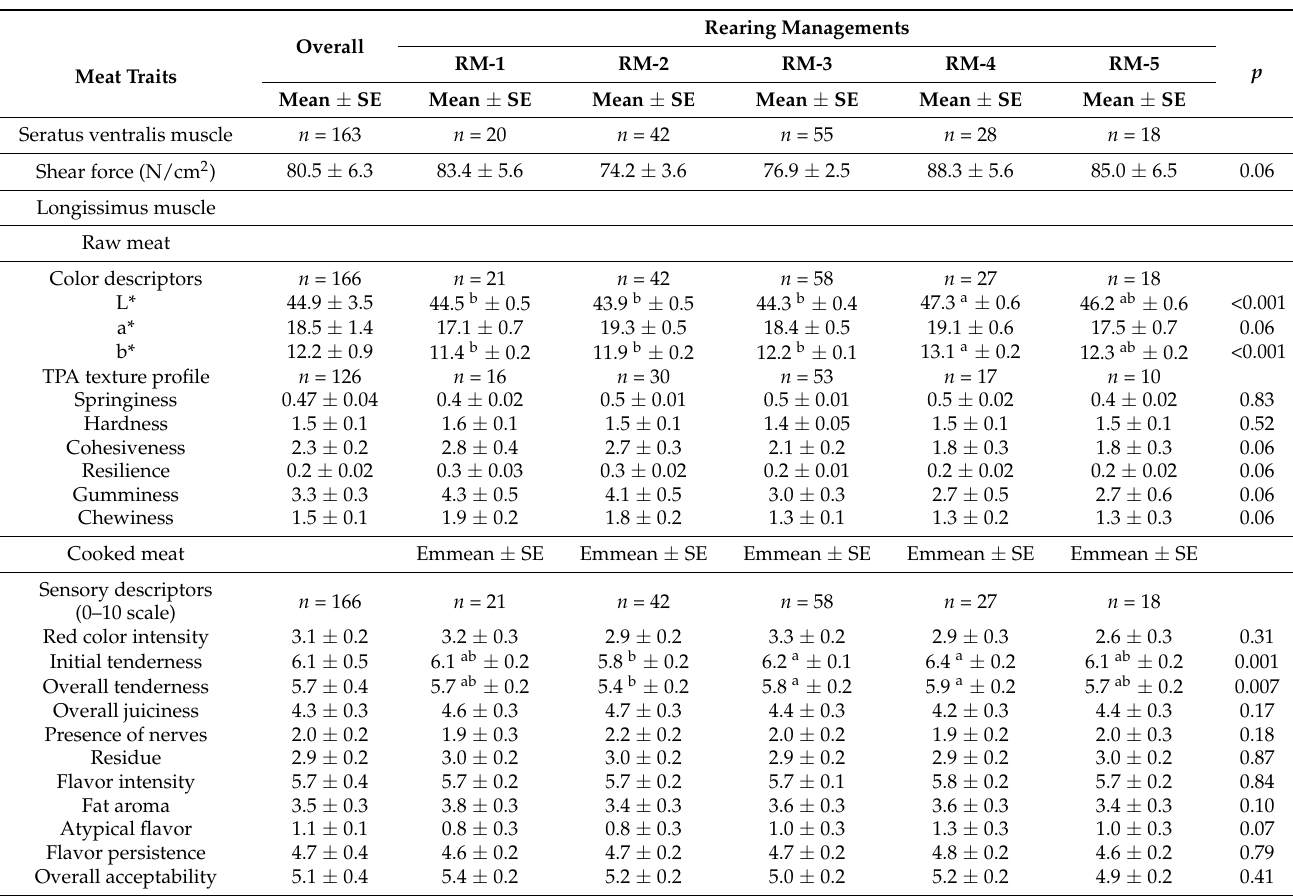
Table 7. Effects of the five rearing managements (RMs), applied throughout the young bulls’ life, on the meat